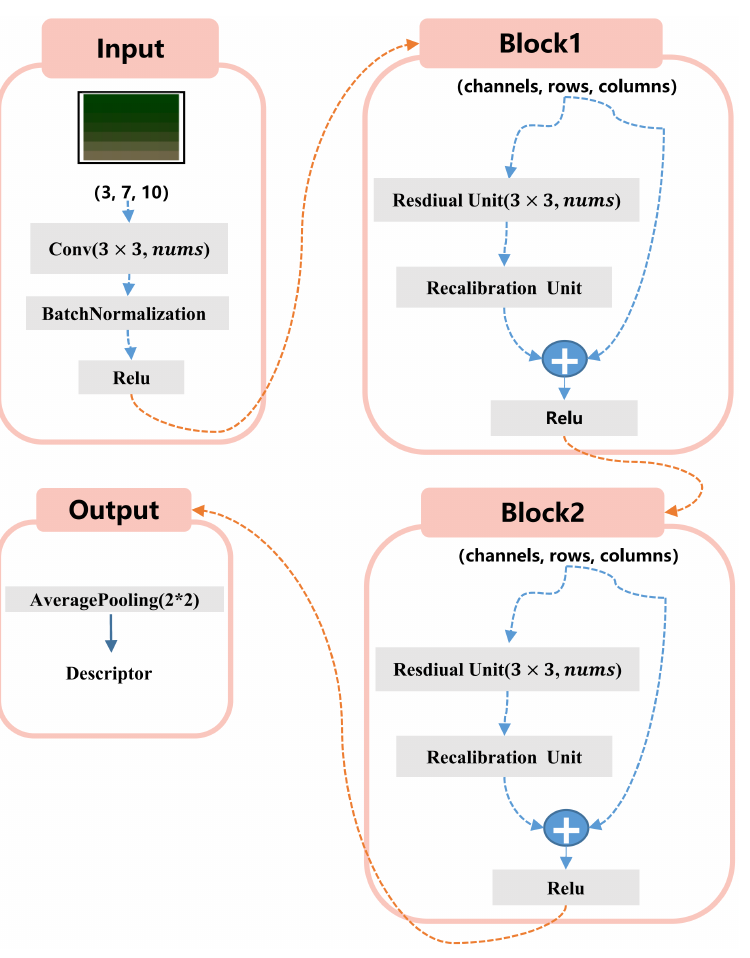
Figure 7. The structure of channel-attention-Net-based encoder which comprised of two basic blocks in this case.